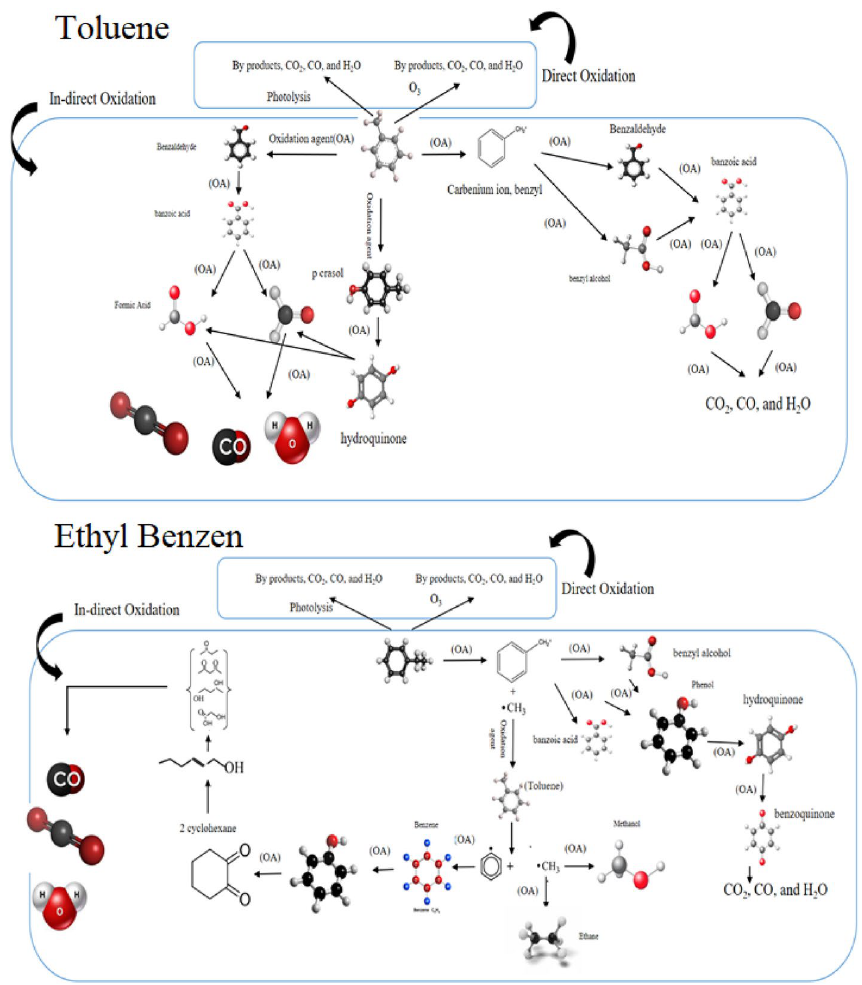
Figure 9. Decomposition probably pathways for toluene and ethylbenzene by